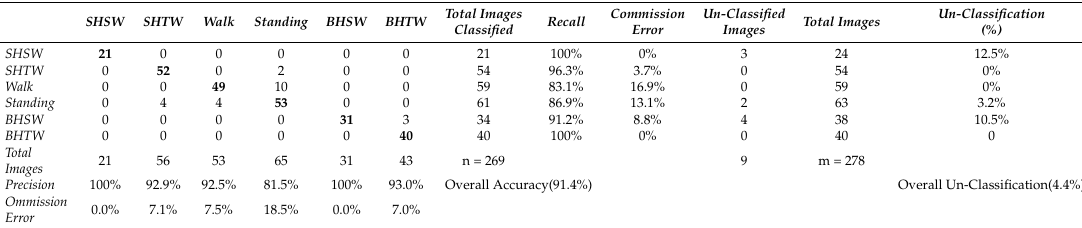
Table 2. Classification matrix for Daria images.